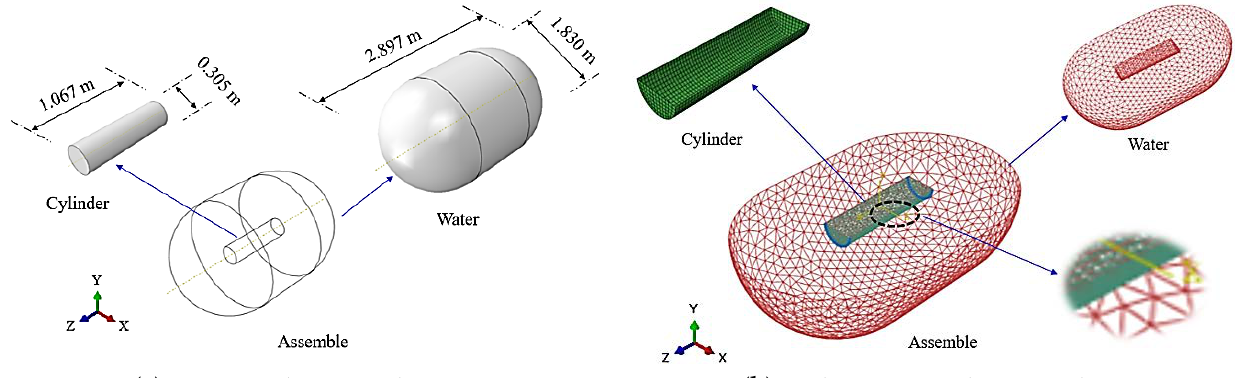
Figure 3. Schematic of numerical model.